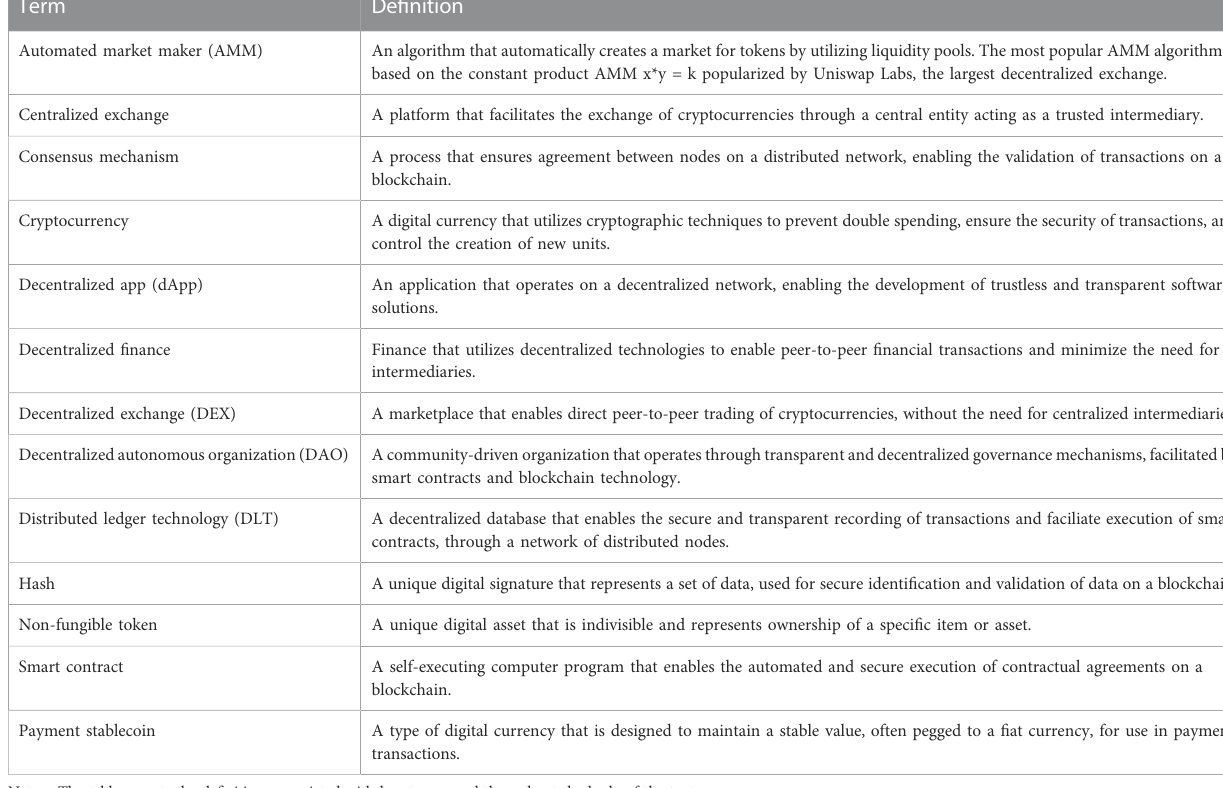
TABLE 1 De fi nitions for key terms. Term De fi